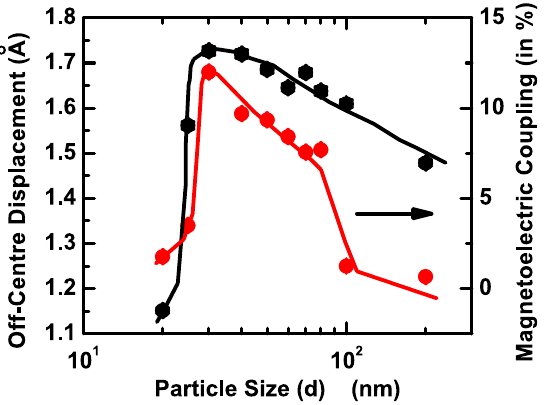
Figure 5. Particle size dependence of off-centre displacement within a cell and magnetoelectric